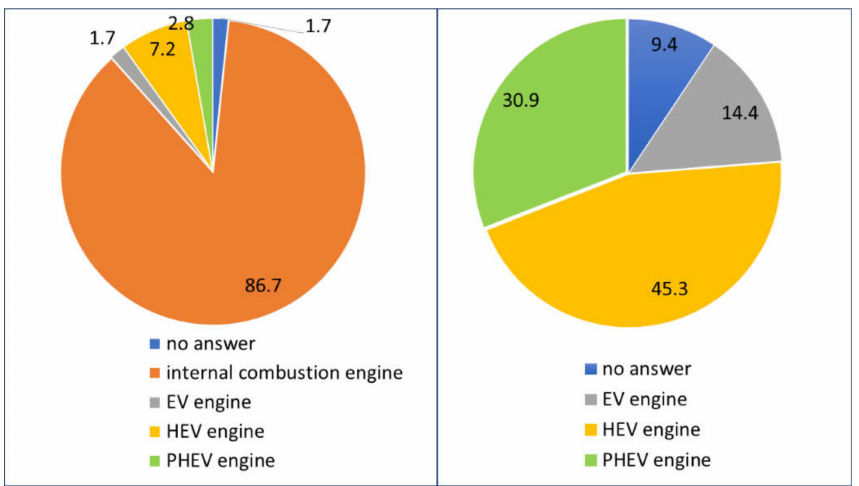
Figure 2. Engine type of the future car ( left panel); Engine type of the hypothetical purchase of AFV ( right panel), N =